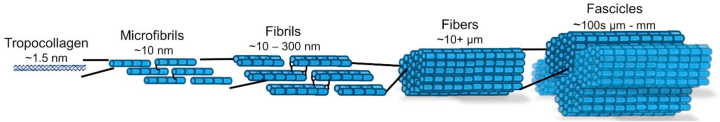
Hierarchical collagen organization with relative diameters of sub-level organization.